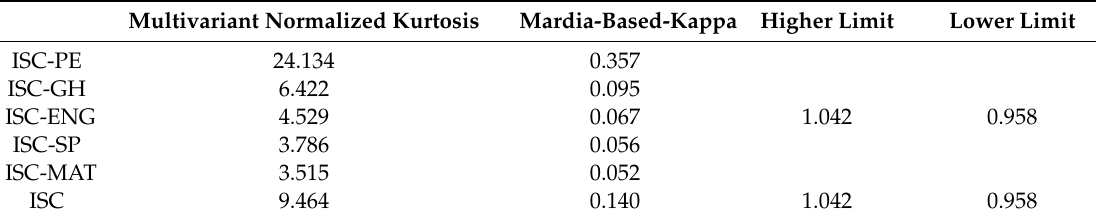
Table 1. Values of multivariate normality test.